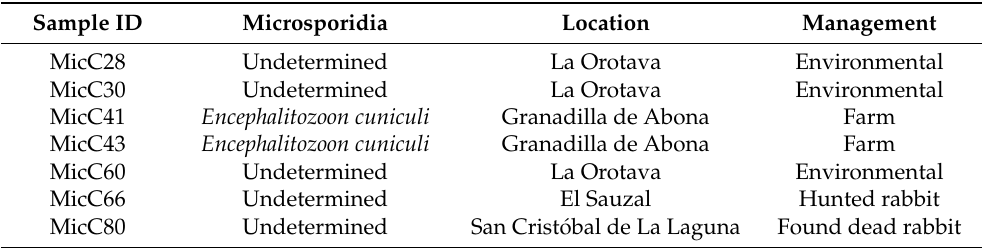
Table 1. Microsporidia detected in rabbit fecal samples and location in Tenerife, Canary Islands